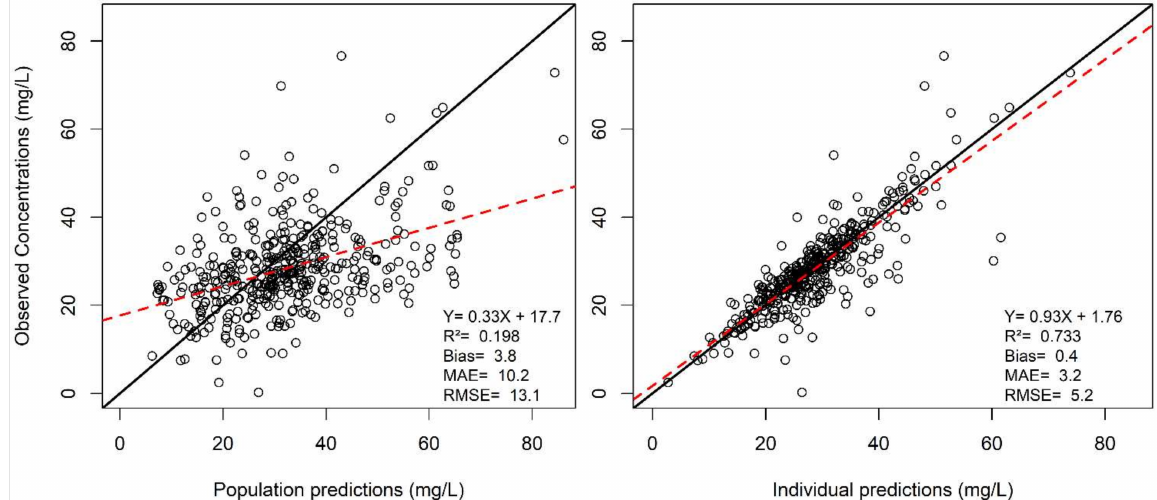
Figure 3. Observed vs. predicted concentration in the validation